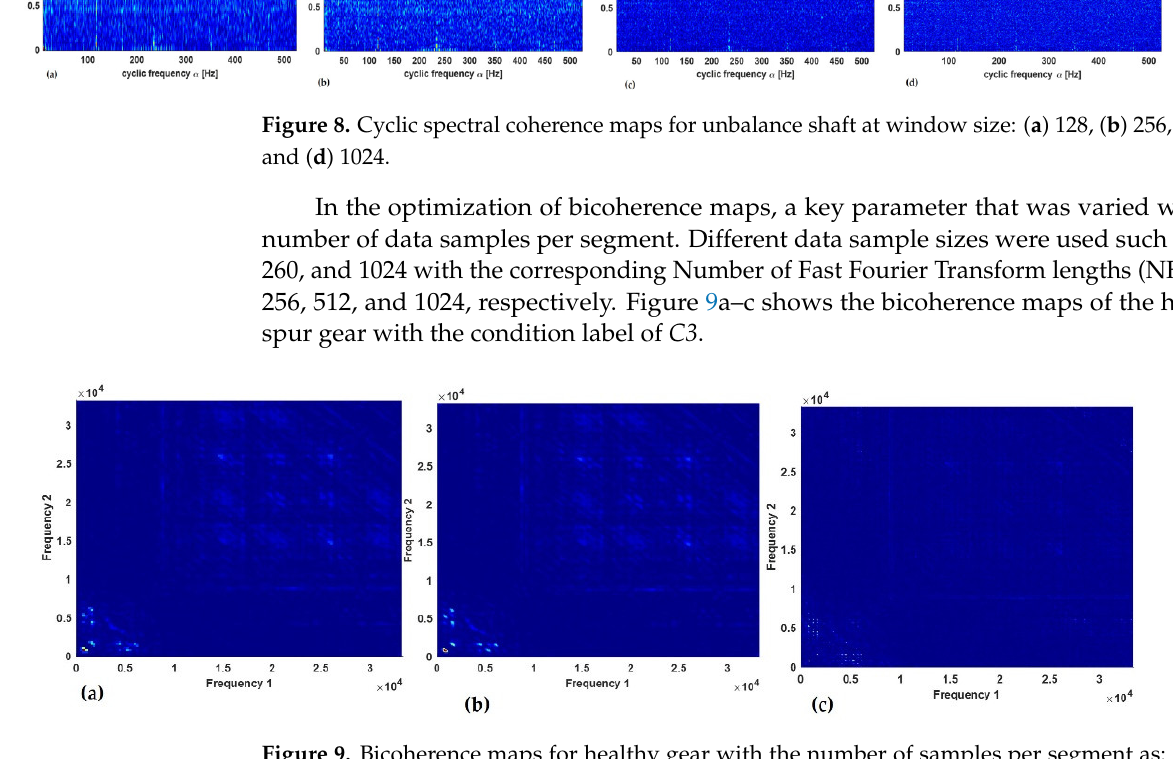
Figure 9. Bicoherence maps for healthy gear with the number of samples per segment as: ( a ) 256, ( b ) 260, and ( c ) 1024.